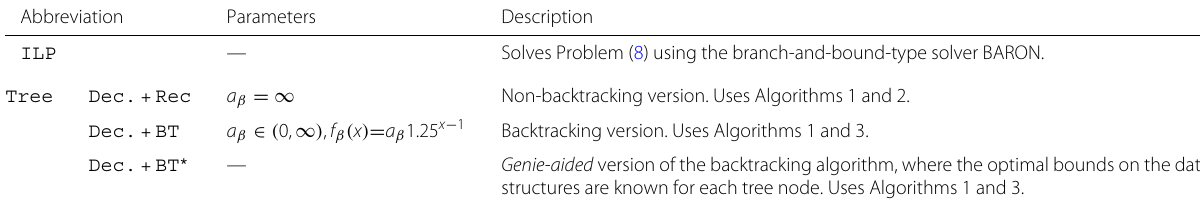
Algorithm 3: Backtracking-based TARP-Solver using dynamic programming on a k -ambiguity